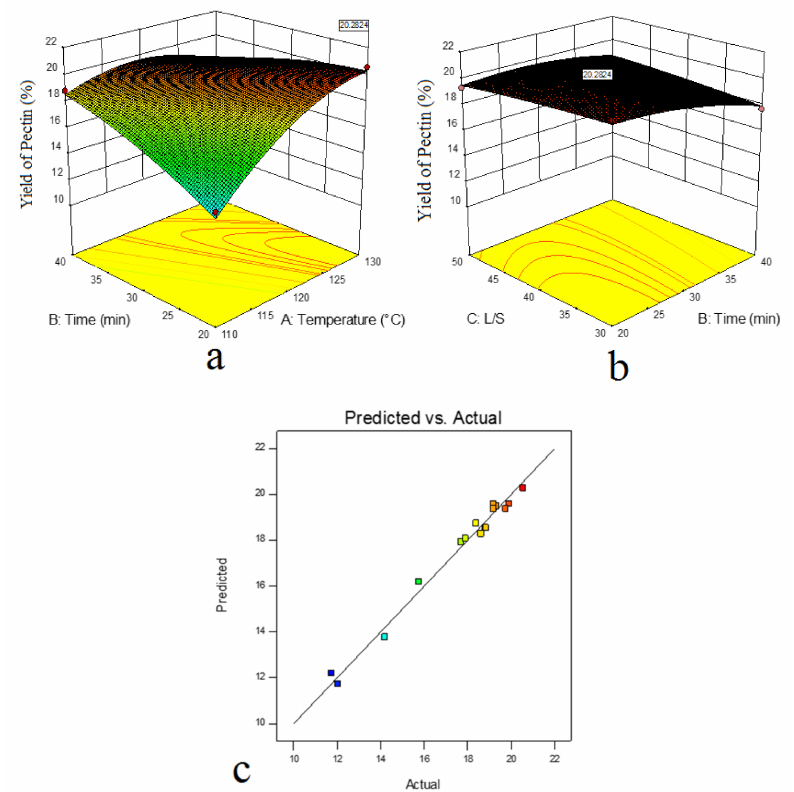
Figure 1. Response surface plots showing the effect of the interaction: ( a ) between temperature and time (L/S ratio: 0), ( b ) between time and L/S ratio (temperature: 0), ( c ) correlation between predicted and actual